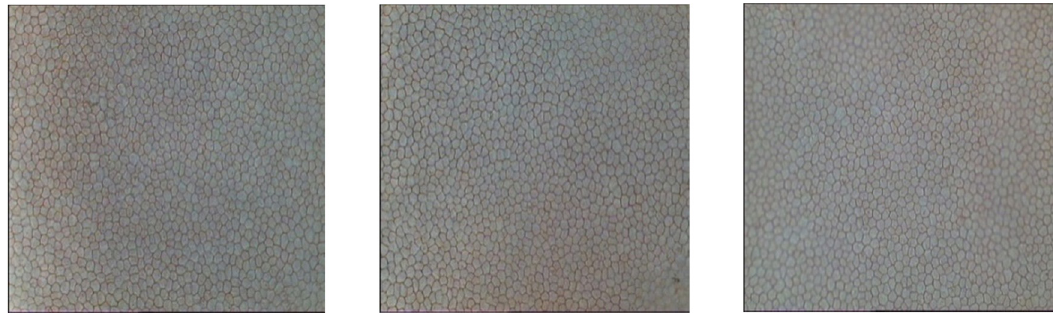
Figure 2: Image dataset examples of specular microscopy.